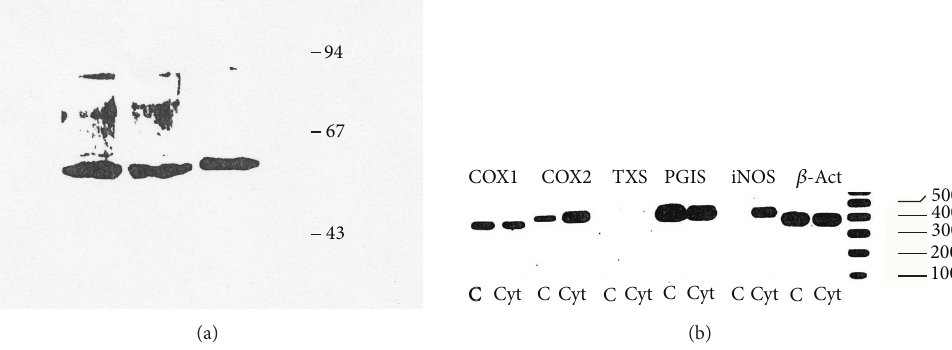
Figure 5: (a) Western blotting of prostacyclin synthase in HMC. Cell lysates (80 𝜇 g) of cytokine treated HMC or control were stained with a polyclonal antibody for PGIS. Lane 1: control; lane 2: cytokine stimulation; lane 3: positive control (partially purified protein of bovine PGIS with a molecular mass of 52 KD); lane 4: molecular marker. (b) mRNA analysis of prostanoid generating enzymes and iNOS in HMC. RT-PCR analysis of the mRNA for COX1, COX2, TXS, PGIS, and iNOS from quiescent human mesangial cells (2 × 10 6 ) was treated for 20h with cytokines or vehicle. RNA preparation and PCR analysis were performed as described in Material and Methods. A 100bp ladder is given on the right to evaluate the mass of the amplified